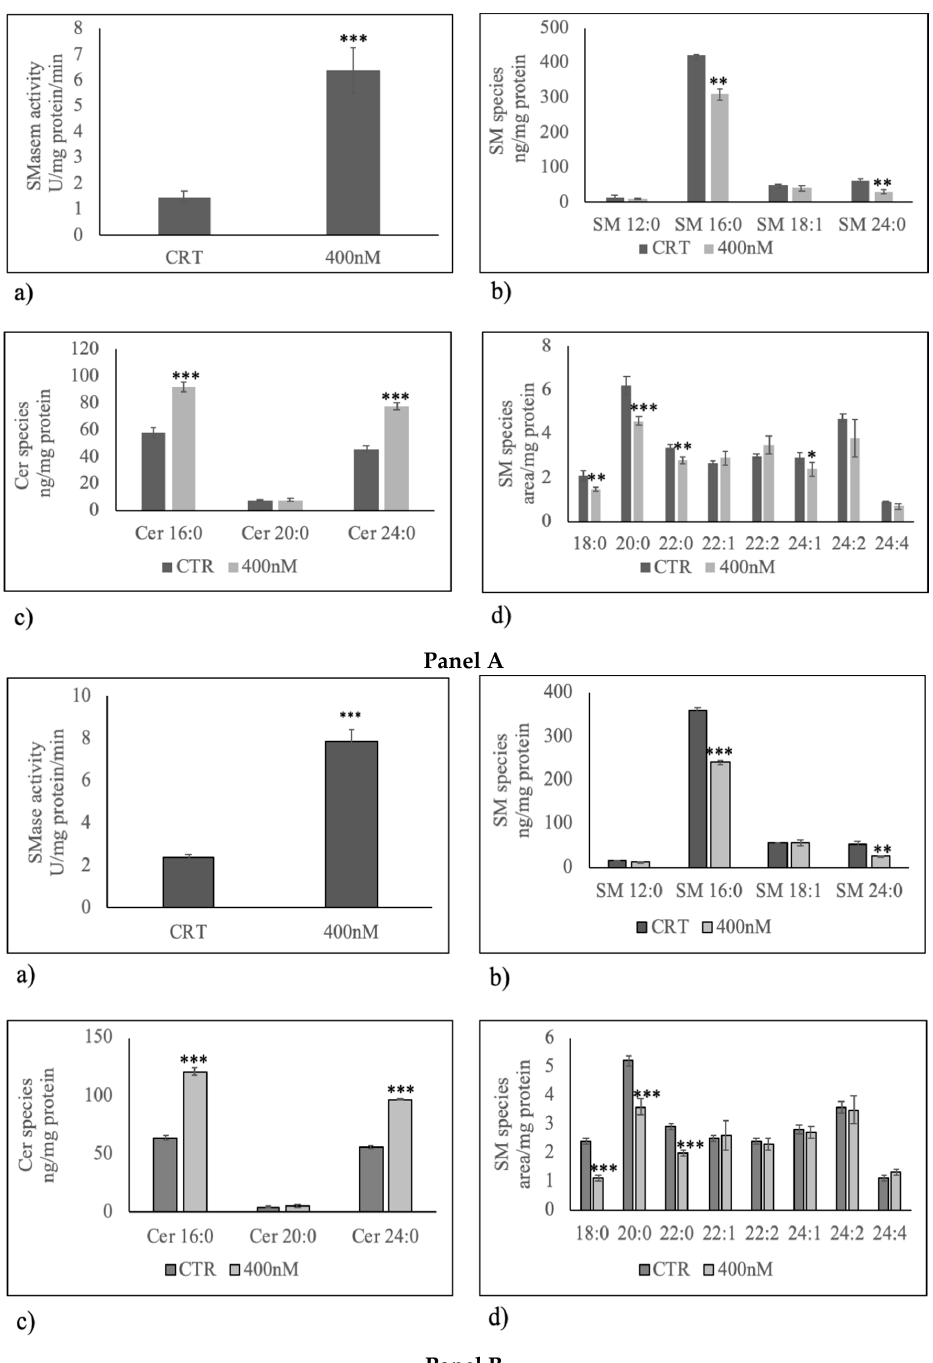
Figure 4. Effect of 400 nM 1 α ,25(OH) 2 D 3 on sphingomyelin (SM) breakdown. Panel A, U251 cells; Panel B, LN18 cells. ( a ) Sphingomyelinase activity. The enzyme activity was evaluated by using the Amplex Red Sphingomyelinase assay kit, as reported in the “Materials and Methods” section. Data were expressed as mU/mg protein/min; ( b ) SM species studied by using 16:0 SM, 18:1 SM, and 24:0 SM external calibrators. Data are expressed as nmol/mg protein; ( c ) ceramide species studied by using Cer 16:0, Cer 20:0, Cer 24:0 external calibrators. Data are expressed as nmol/mg protein; ( d ) SM species evaluating the areas of all the peaks identified on the basis of their molecular weight. Data are expressed as area / mg protein. Data are expressed as the mean ± S.D. of 3 independent experiments performed in duplicate. ∗ p < 0.05, ∗∗ p < 0.01, ∗∗∗ p <